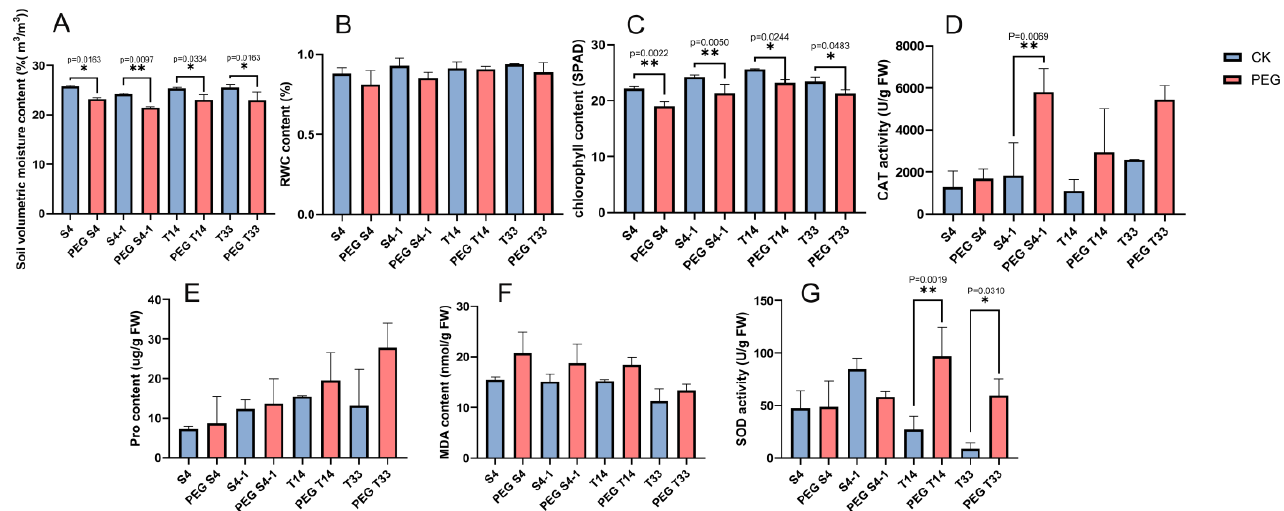
Figure 1. Physiological characteristics of drought-sensitive and drought-resistant sorghums under control and PEG stressed conditions. Measurements of the soil volumetric moisture (%(m 3 /m 3 )) ( A ), RWC (%) ( B ), chlorophyll (SPAD) ( C ), CAT activity (U/g FW) ( D ), Pro (ug/g FW) ( E ), MDA (nmol/g FW) ( F ), and SOD activity (U/g FW) ( G ). Bars represent the mean ± SE (n = 3). Data represent the mean ± variance of three biological replicates, and statistical significance was measured using one- way ANOVA with Tukey’s test. * p < 0.05 and ** p < 0.01 between treatments and their respective controls.